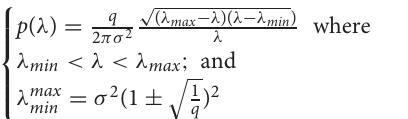
FIGURE 2 | Schematics of NA detection: Spikes are recorded from a pool of cortical cells (A) , forming a set of spike trains (B) . The trains are binned and fed into an assembly detection algorithm (C) . A relation matrix is built based on the covariance of spike trains, followed by a PCA assembly detection algorithm identifies neurons with joint activations (pink and orange) and independent neurons (blue) (D) . In this work, functional NAs are defined by time-specific coherent modulations in the firing rate. Notice that one neuron may participate in more than one